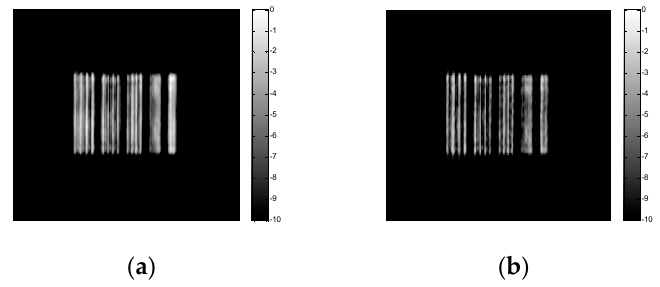
Figure 14. Imaging results of the resolution board in experiments before and after calibration, ( a ) is the imaging result before calibration and ( b ) is the imaging result after calibration.